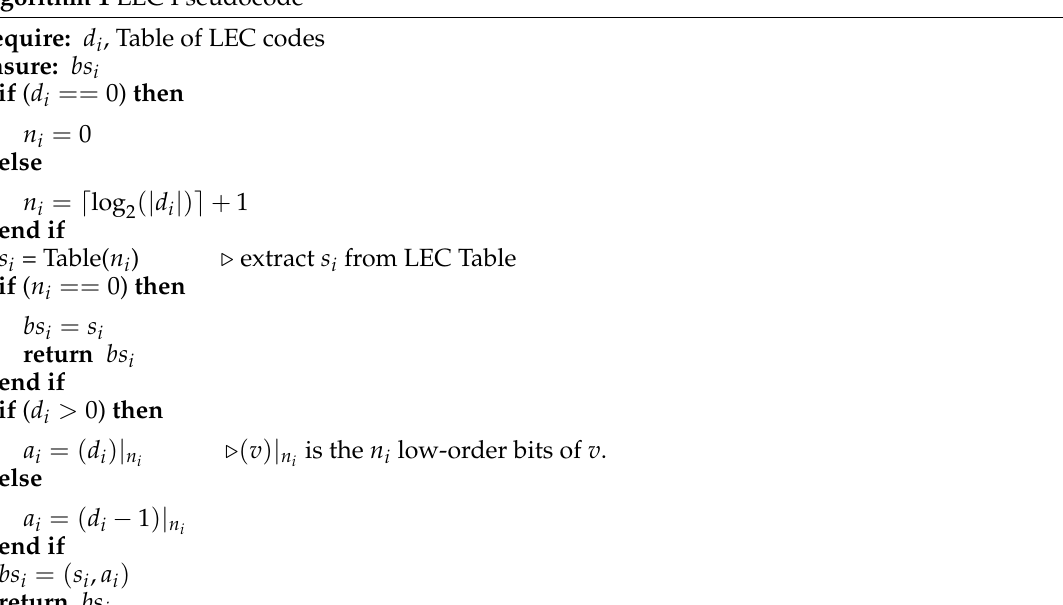
Algorithm 1 LEC